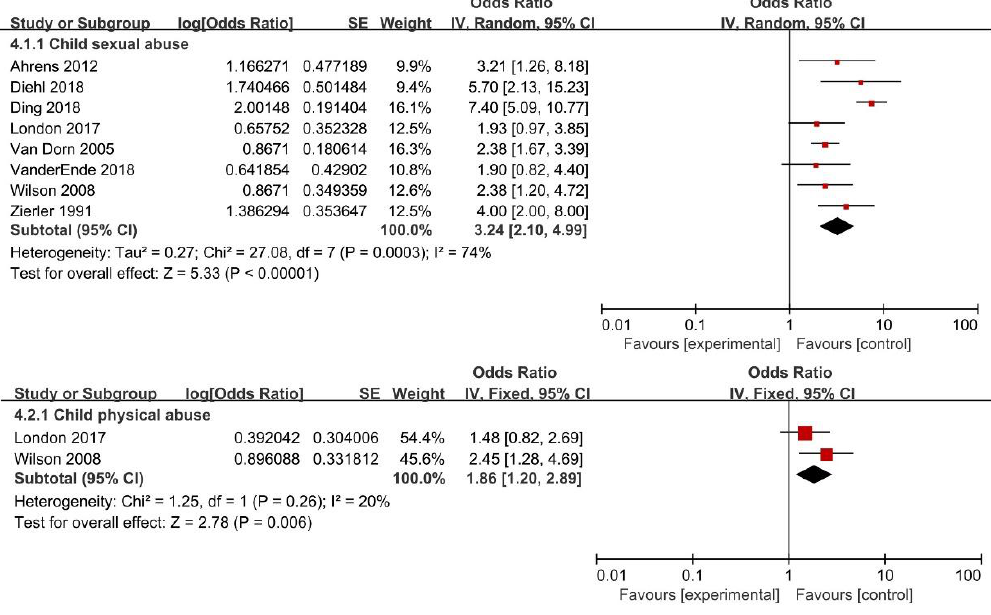
Figure 4. Forest plot for subtypes of childhood maltreatment and risk of having multiple sexual partners.